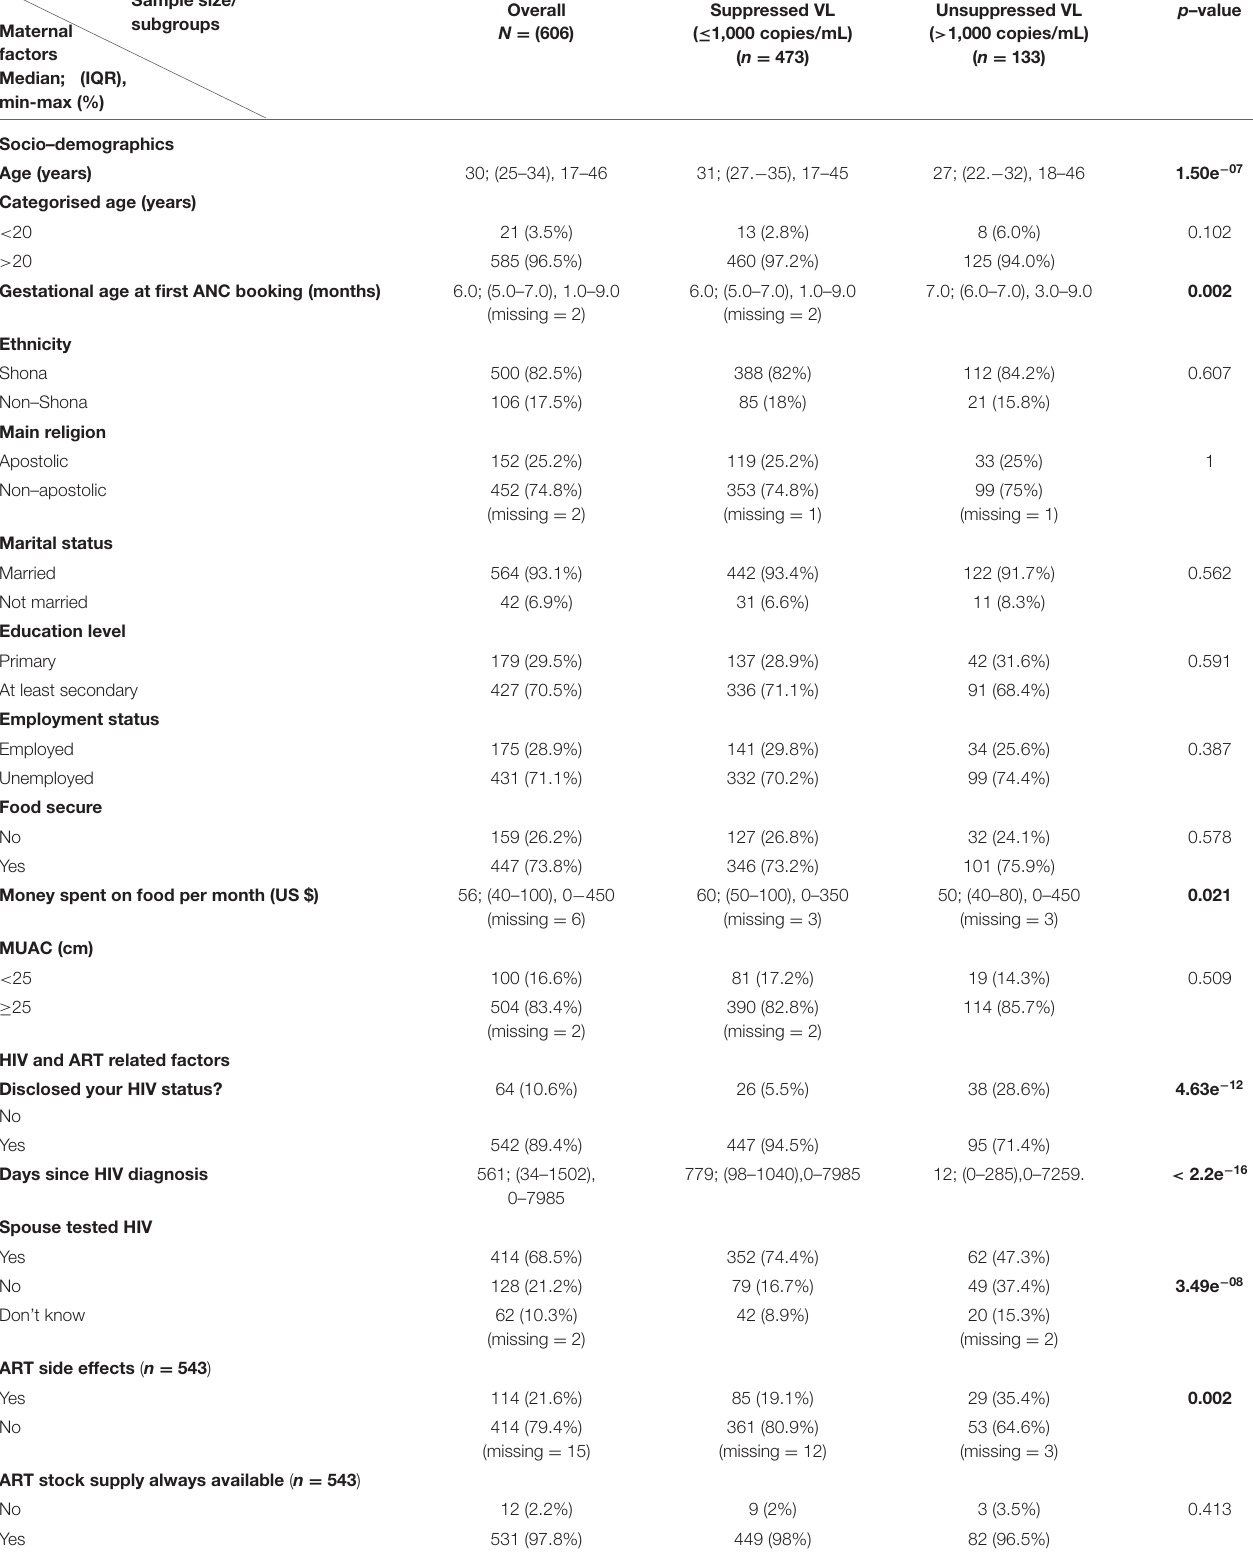
TABLE 3 | Parameters associated with VS ( ≤ 1,000